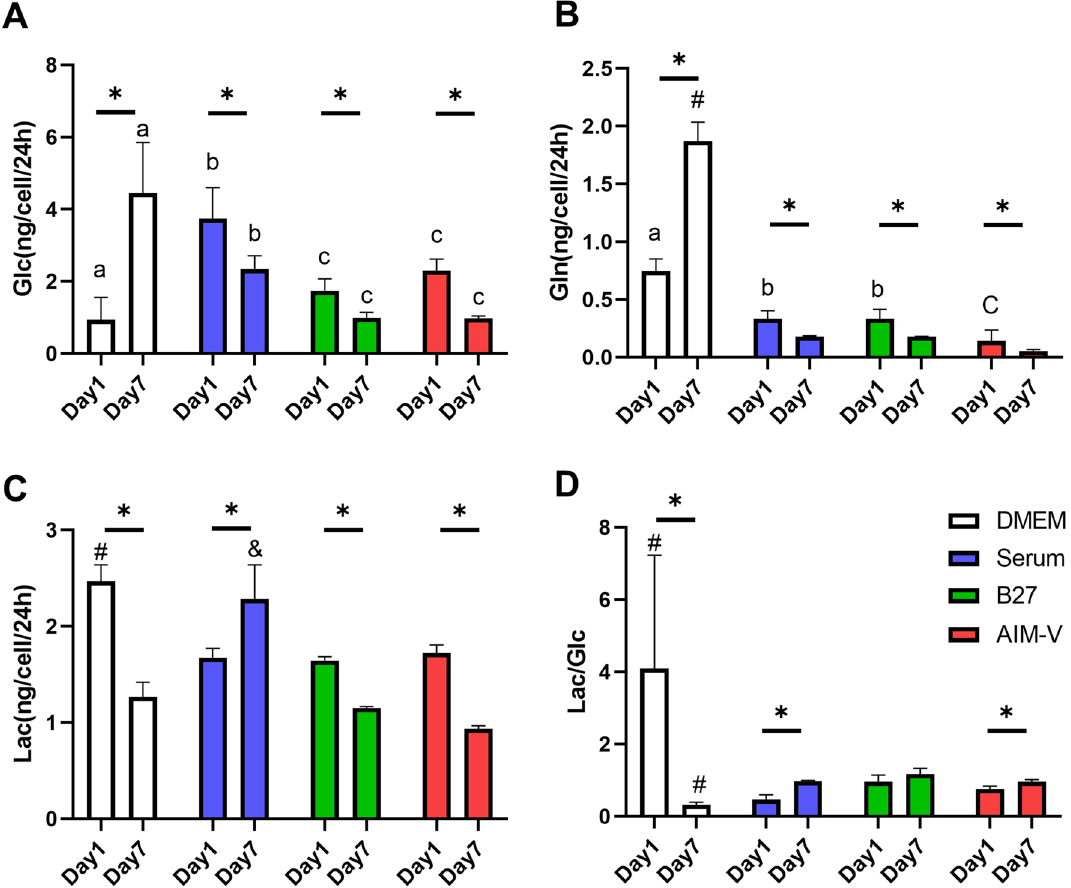
Figure 4. The rates of consumption and secretion of extracellular metabolites at day 1 (myoblasts) and day 7 (myotubes) in DMEM, Serum, B27, and AIM-V cultures. The medium was collected from day 0 to 1 and 6 to 7, representing day 1 and 7, respectively. ( A ) The rate of glucose consumption. ( B ) The rate of glutamine consumption. ( C ) The rate of lactate secretion. ( D ) The ratio of lactate secretion to glucose production. (n) = 4. The student’s t-test was performed to compare day 1 and day 7 in each different culture. *p < 0.05. One-way ANOVA followed by Tukey’s test was performed for the multiple comparisons. #p < 0.05 versus Serum, B27, and AIM-V at each cultivation day. &p < 0.05 versus DMEM, B27, and AIM-V at each cultivation day. a–c, different letters in the same day indicate the significant statistical difference. Data presented as average ± standard deviation